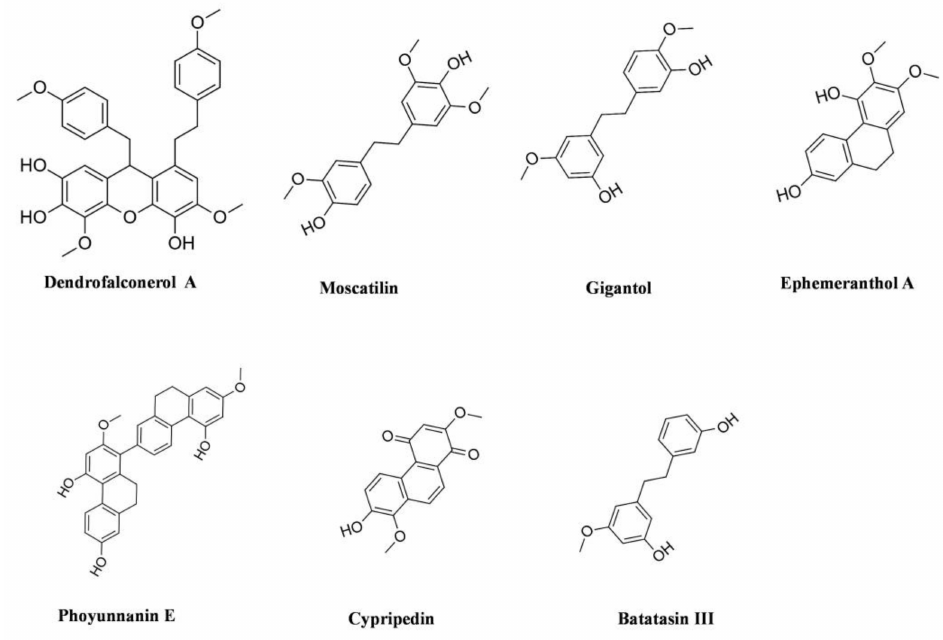
Figure 2. Selected compounds from the Orchidaceae family with anticancer